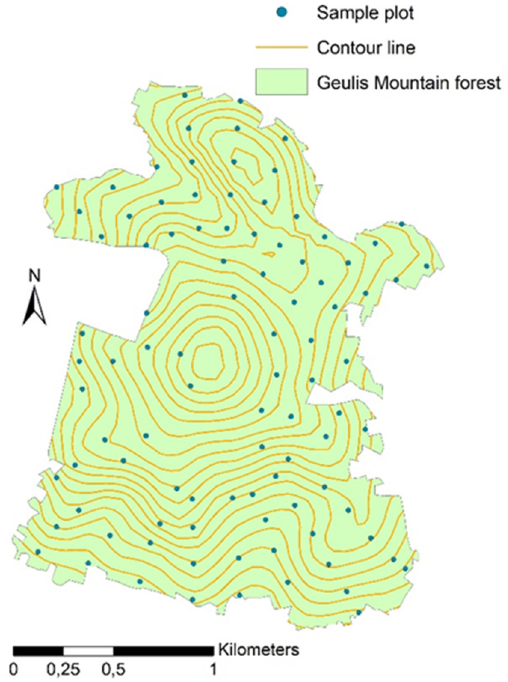
Figure 2. Distribution of sample plots.